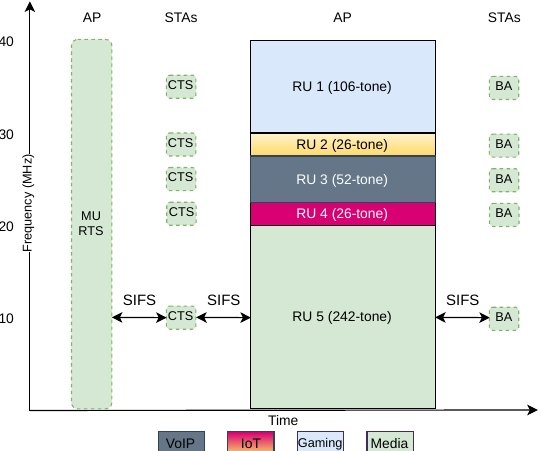
Figure 9. DL MU OFDMA transmission over different RUs and traffic demands within a 40 MHz